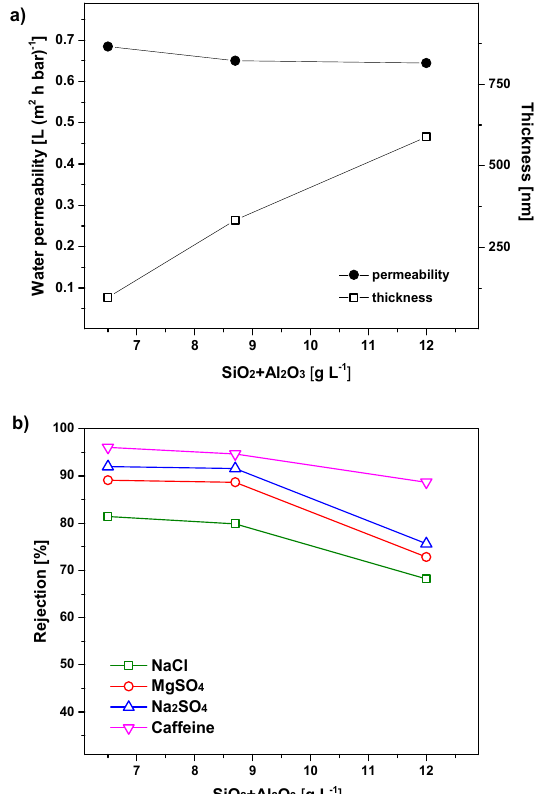
Figure 5. ( a ) Water permeability and thickness of 5 mol% Al 2 O 3 -doped silica membranes as a function of the SiO 2 + Al 2 O 3 concentration in the coating sol. ( b ) Membrane rejection for inorganic salts and caffeine as a function of the SiO 2 + Al 2 O 3 concentration in the coating sol.